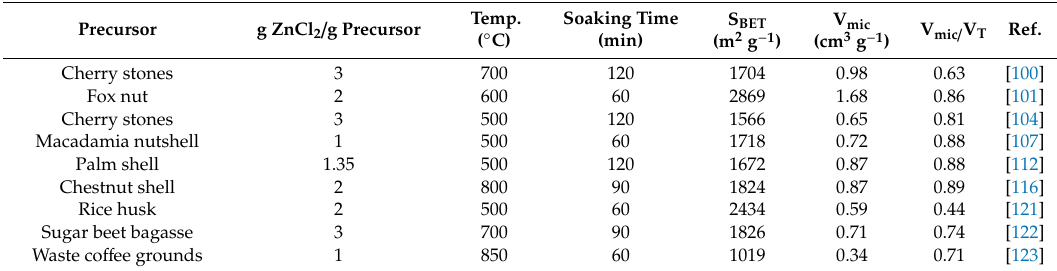
Table 8. Summary of experimental conditions in terms of porosity development of ACs produced by ZnCl 2